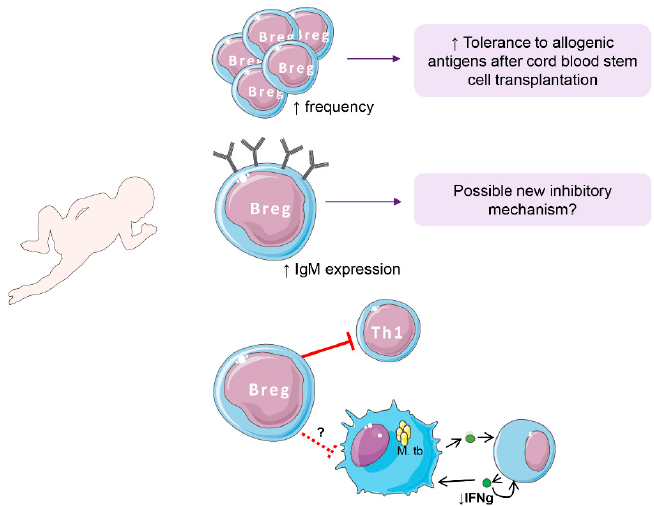
Figure 2. Breg cells in the neonate. Breg cell frequency is increased in neonates, providing improved tolerance to allogenic antigens (i.e., after cord blood stem cell transplantation). Besides, there is a